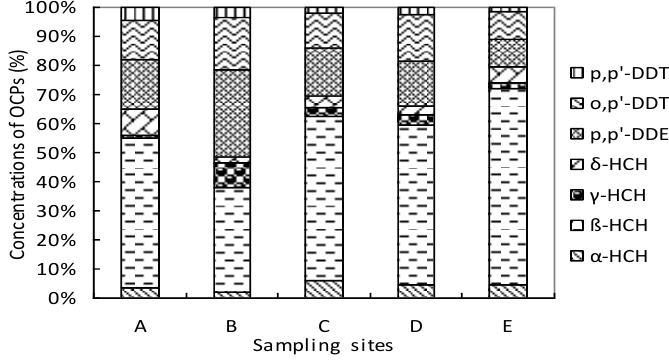
Fig. 2. The composition profiles of OCPs in park soil from Ulaanbaatar city